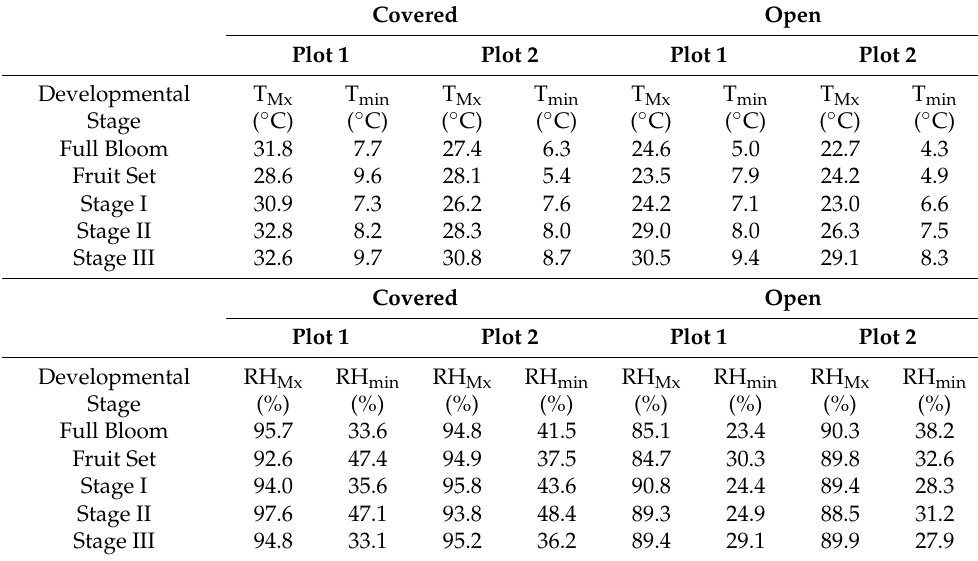
Table 1. Environmental conditions under high tunnels, both covered and in the open, considering Plot 1 (season 2018/2019) and Plot 2 (season 2019/2020). Covered Open Plot 1 Plot 2 Plot 1 Plot